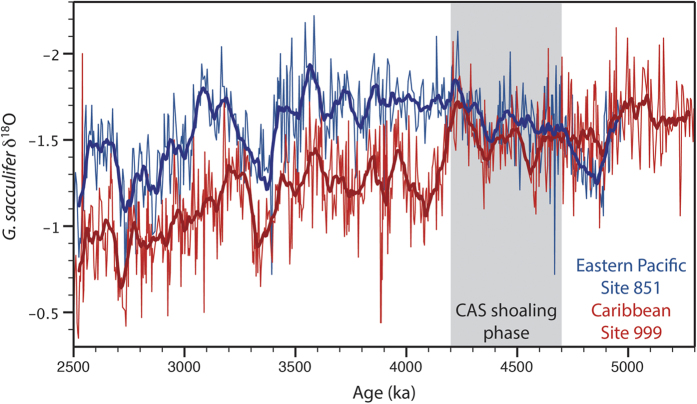
Surface water (planktic) δ18O records (‰ vs Vienna Pee Dee Belemnite) from the Caribbean (Site 999)21 and Pacific (Site 849)62 showing the emergence of a permanent gradient between ~4.7–4.2 Ma, interpreted to reflect a major shoaling phase of the CAS3.Bold lines represent 50 kyr running averages.